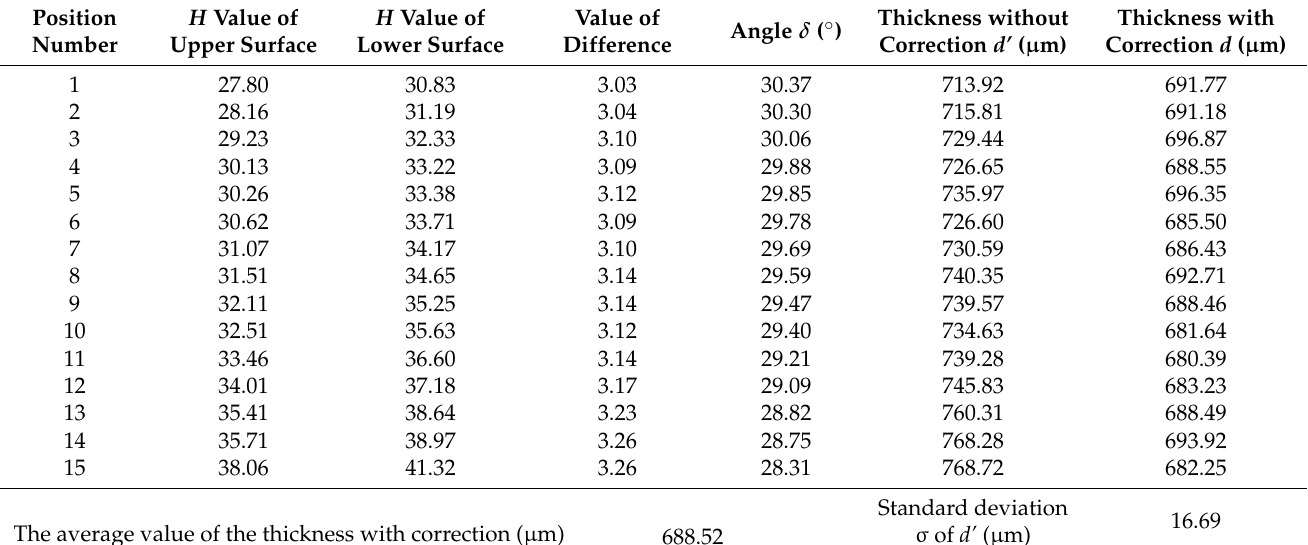
Table 6. Experimental data of the thickness of Sample 3.